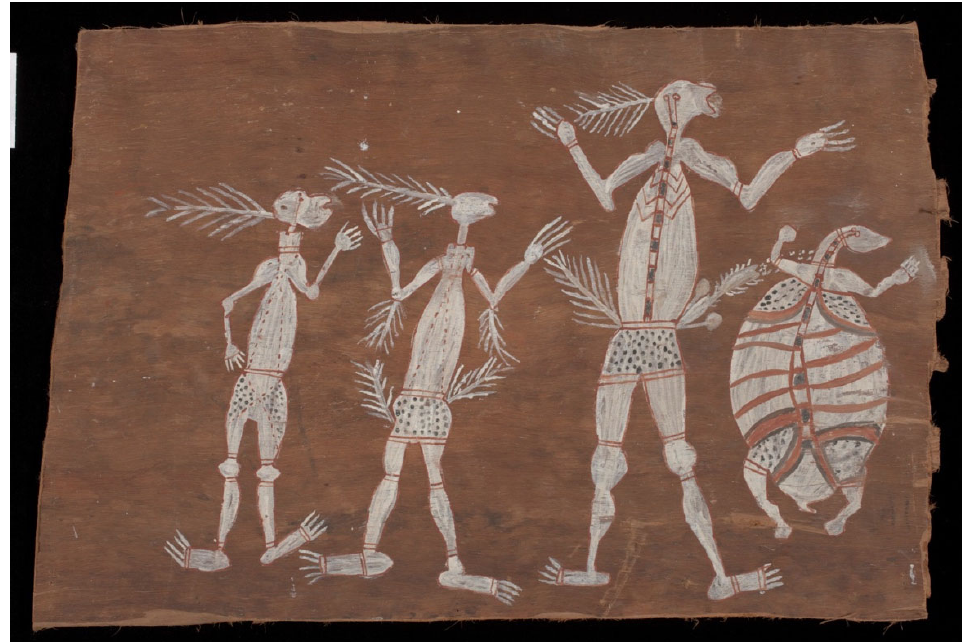
Figure 1. Yirawala, ‘Three Mimi men, spirits of rock, and turtle’, 1963, 550 × 750 cm, ochre on eucalyptus bark, Dr. Karel Kupka Collection. Photography National Museum of Australia. Copyright Yirawala/Aboriginal Artists Agency.